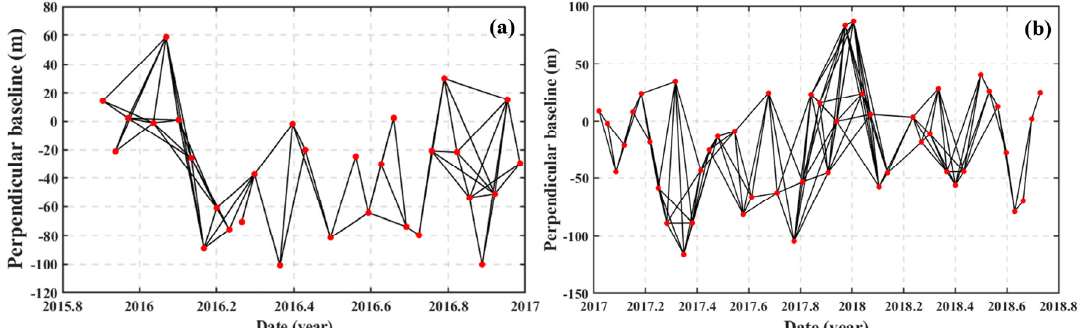
Figure 3. Baseline distribution of high-quality interferometric pairs used in this study. ( a ) Group I of SAR images, acquired from November 2015 to December 2016; ( b ) Group II of SAR images, acquired